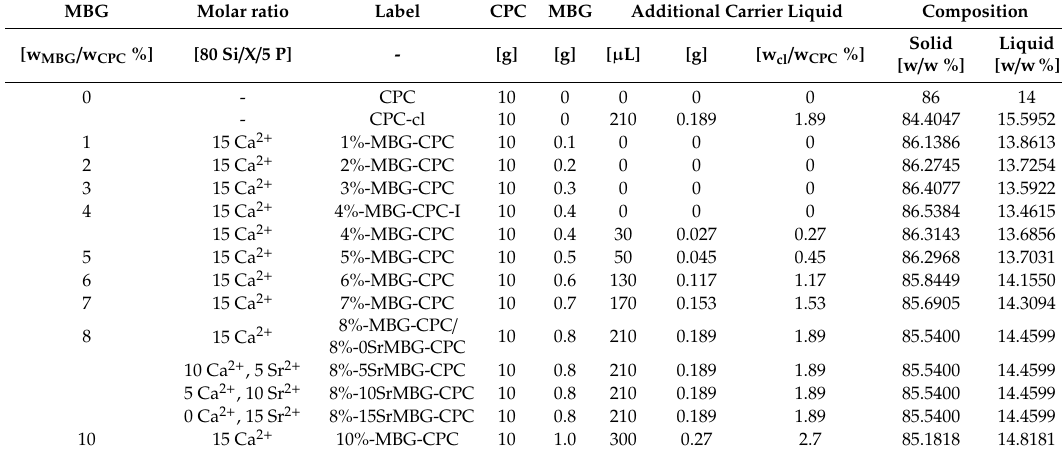
Table 1. MBG-CPC composites of di ff erent concentrations investigated in this